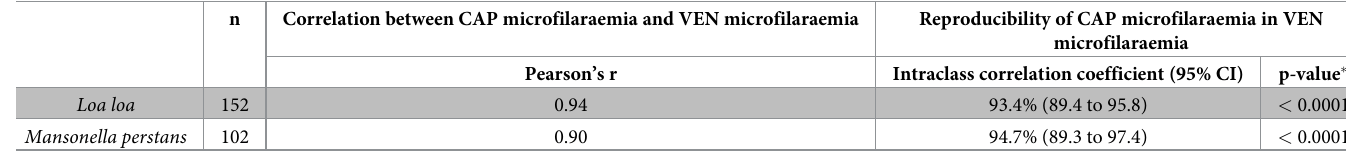
Table 3. Correlation between capillary (CAP) and venous (VEN) microfilaraemia and reproducibility of CAP microfilaraemia in VEN blood. n